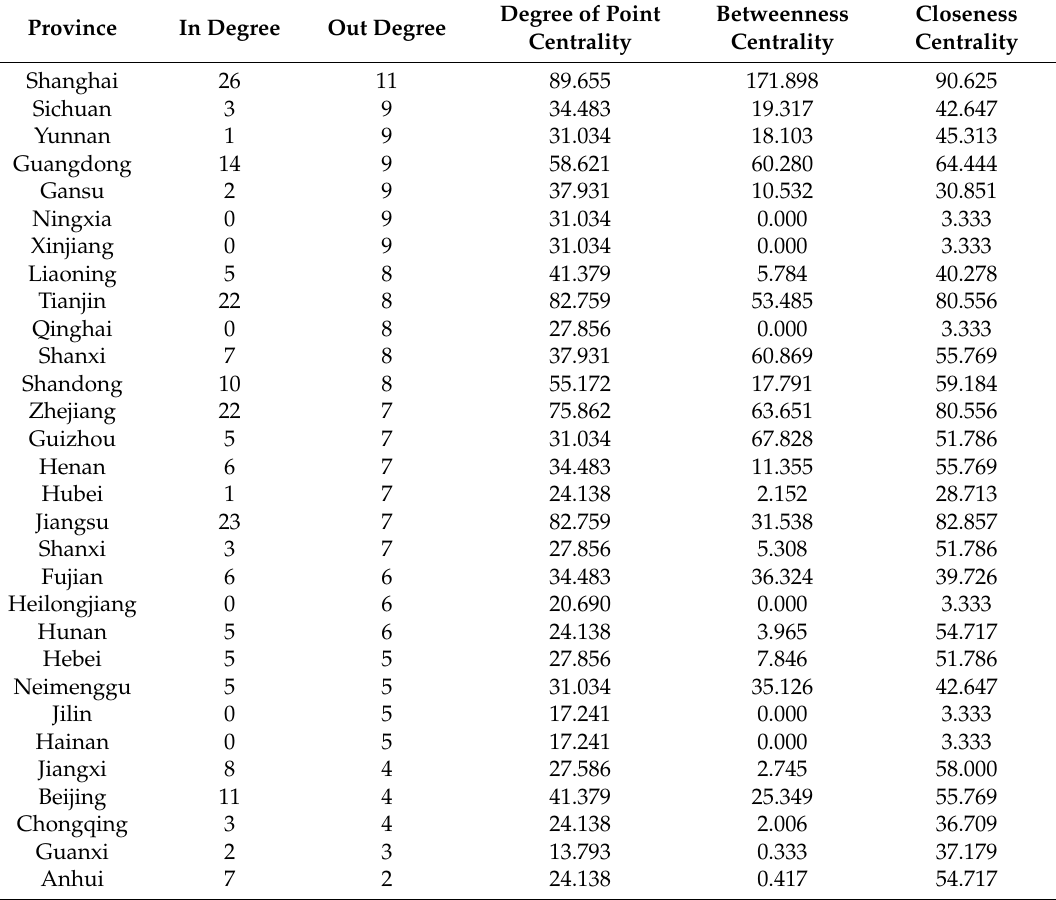
Table 1. Central analysis of spatial correlation networks of carbon emissions in various provinces in